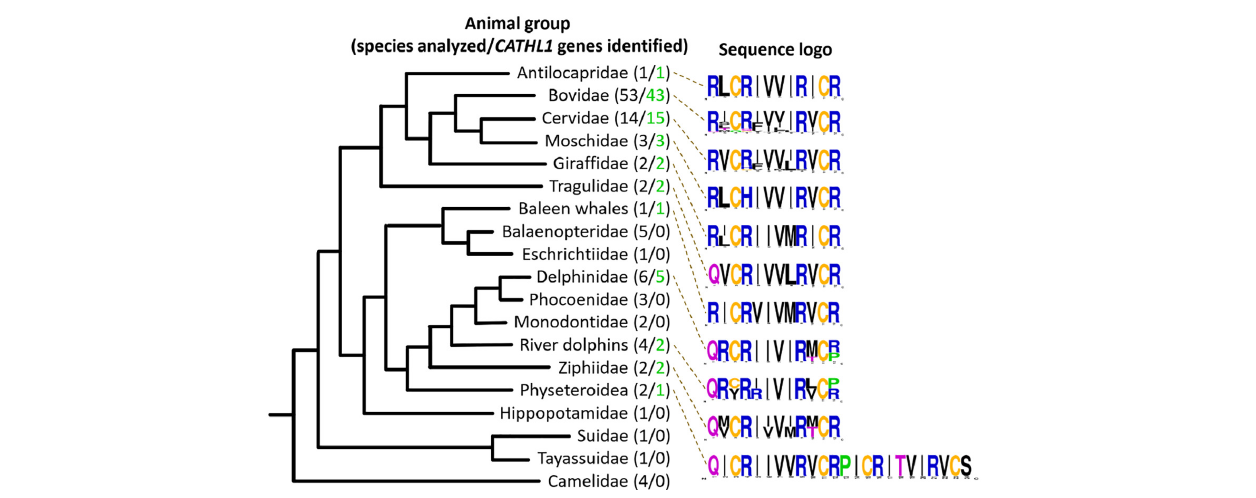
FIGURE 2 | Analysis of CATHL1 genes orthologs from the Cetartiodactyla clade. Target genes were identified in the whole-genome shotgun (WGS, GenBank) database. The presented Cladogram was adapted from Beck et al. (2006). Amino acid frequency (sequence logo) graph was plotted using the WebLogo server